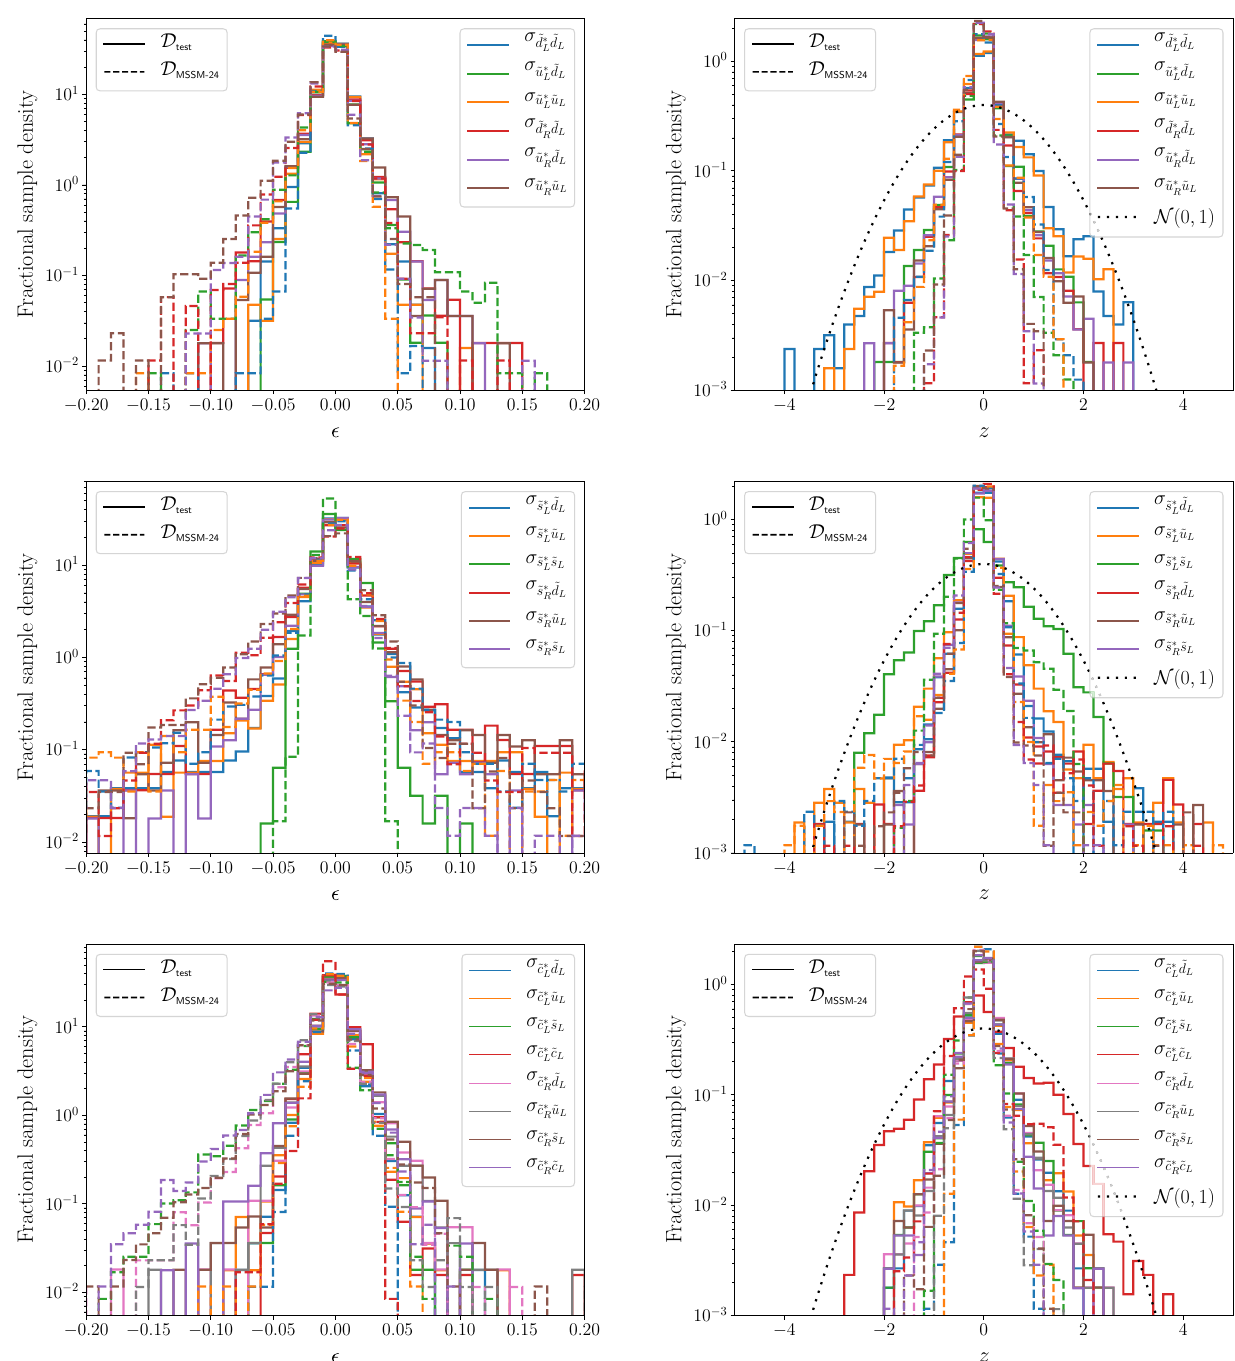
Fig. 14 The relative error (left) and residual (right) distributions for the first and second-generation squark–anti-squark cross-sections for the test sets D test (solid) and D MSSM-24 (dashed)